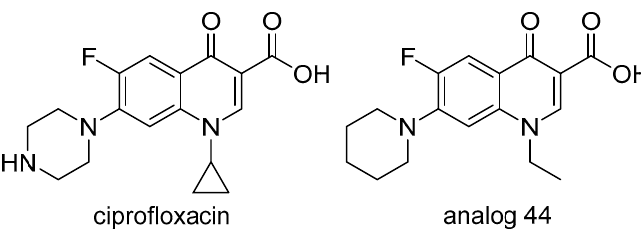
Figure 12. Structure of the fluoroquinolone ciprofloxacin and structure-optimized analog 44 with increased specificity against plants DNA gyrase and better herbicidal profile.